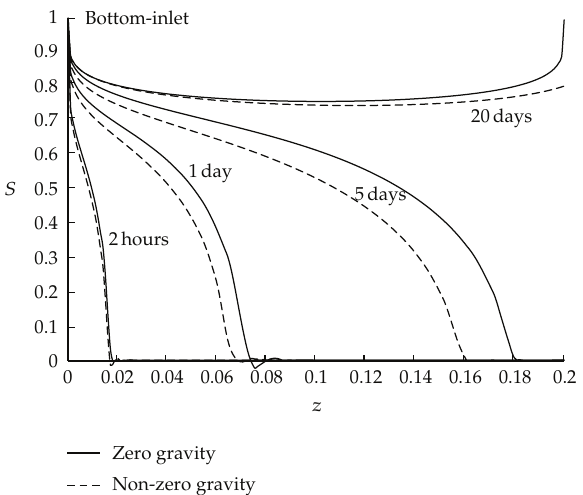
Figure 15: Comparison between considering and neglecting gravity e ff ect on water saturation for the bottom-inlet case, at x (cid:8) 0 .